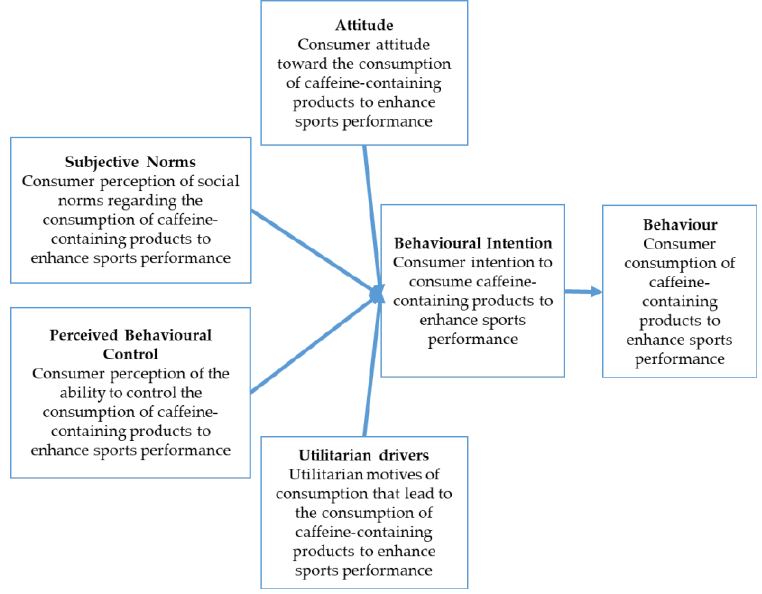
Figure 1. Extended model of the Theory of Planned Behavior.